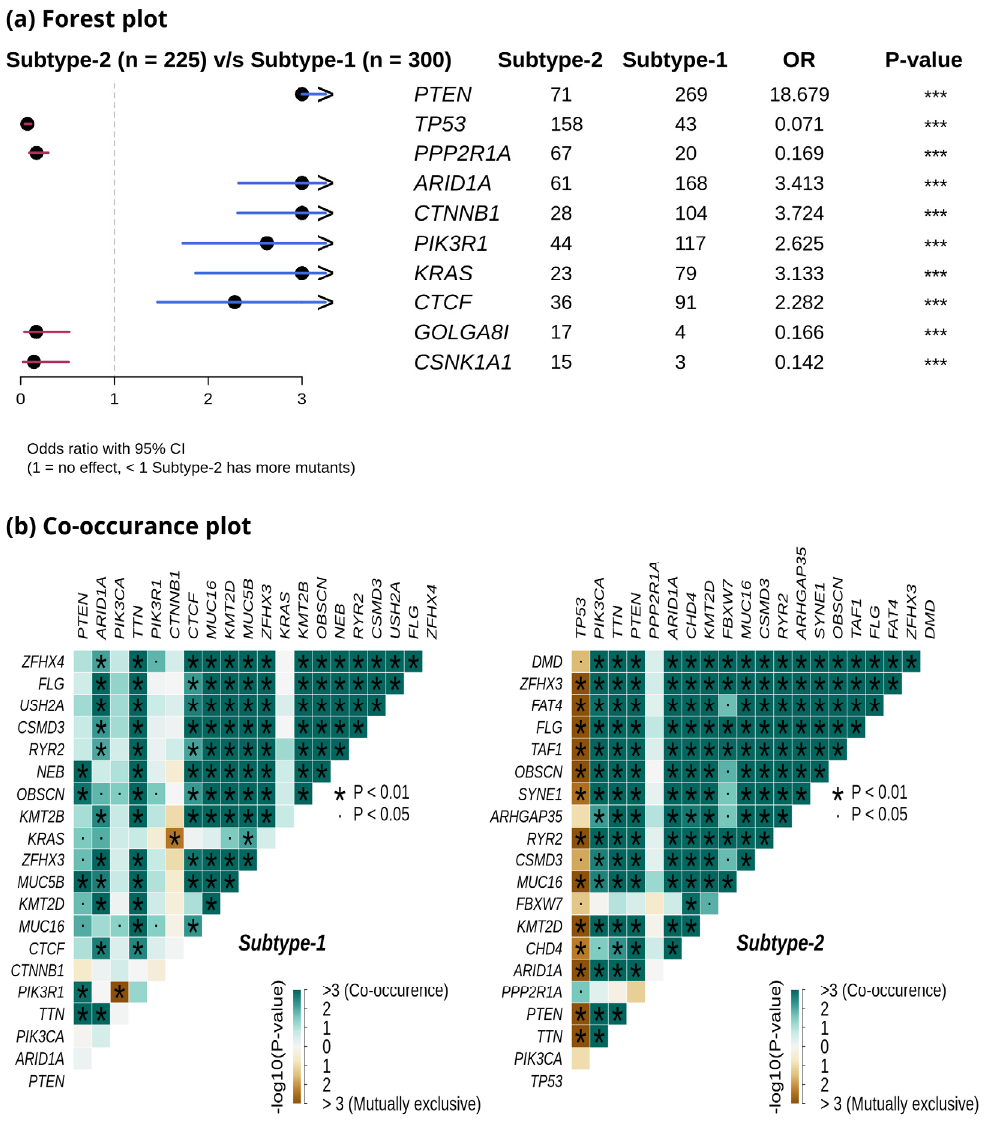
Figure 7. ( a ) Forest plot shows differentially mutated genes between metabolic subtype-1 and subtype-2 samples. The symbol *** represents the p -value < 0.001. ( b ) Co-occurrence analysis between frequently mutated genes of metabolic subtype-1 and metabolic subtype-2 samples.